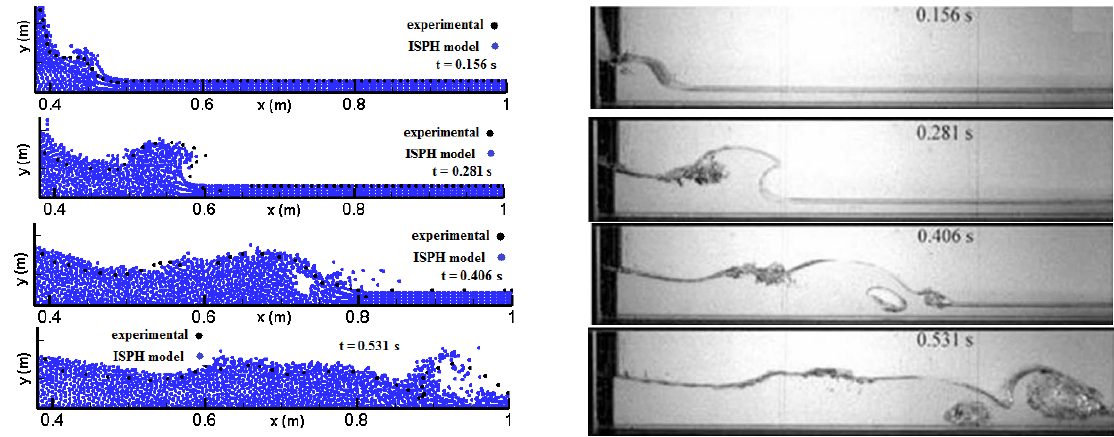
Figure 7 Comparison of (above) numerical results and (below) experimental observations (reprinted from [20]); the observed digitized free-surface position is denoted by the black circle in (a).